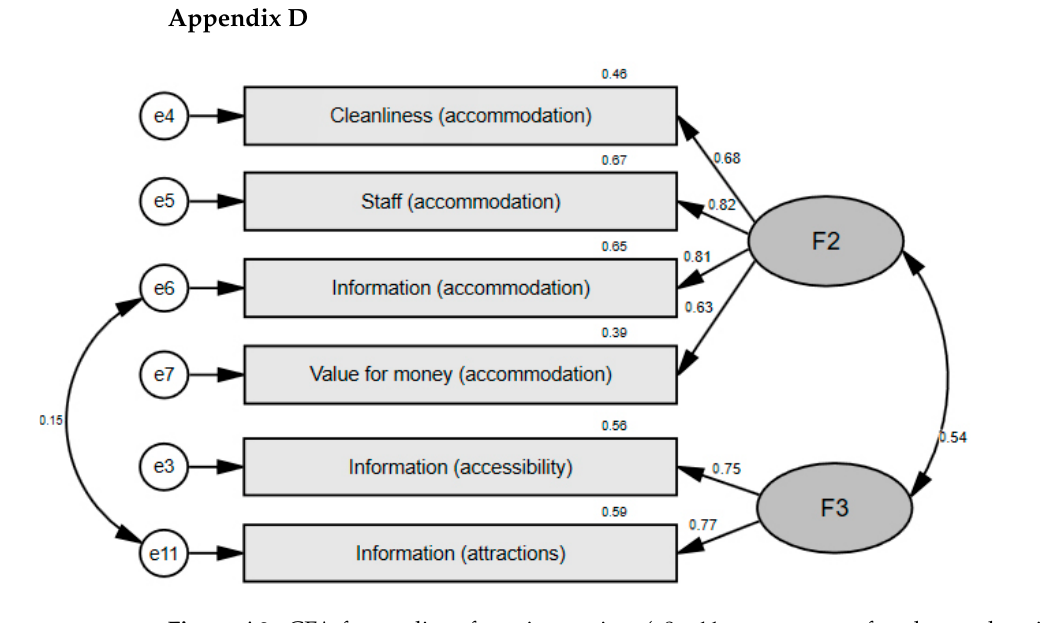
Figure A2. CFA for quality of tourist services (e8–e11—error terms for observed variables; F2— Quality of accommodation and F3—Quality of accessibility and attractions).